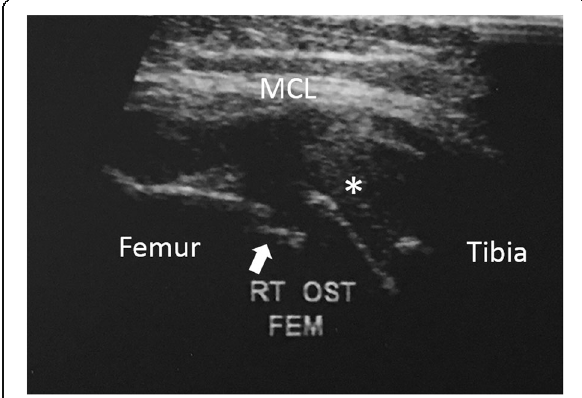
Fig. 2 A 60-year-old male patient complained of right knee stiffness. Longitudinal plane MSK US at the MCL revealed medial extrusion of the degenerated medial meniscus (asterisk) and a medium-sized femoral osteophyte (white